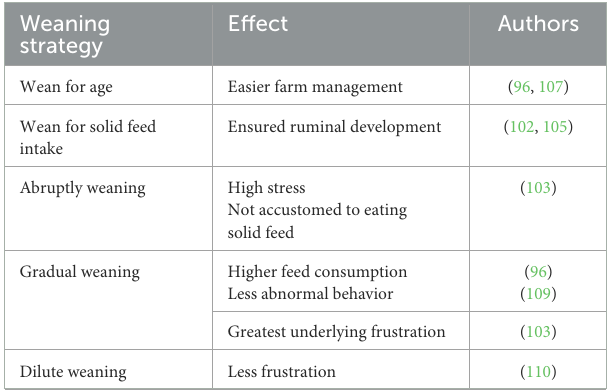
TABLE 4 Weaning strategies and their effects that each of them has on the calf, according to the different